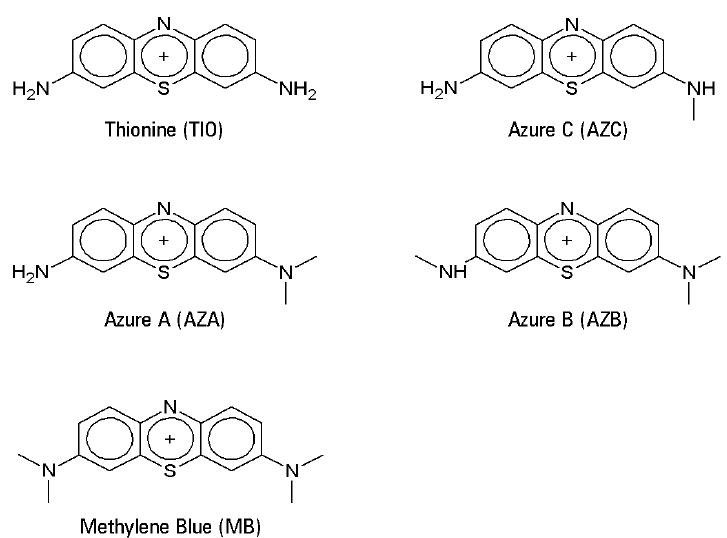
Figure 2. Azure C (monomethylated), Azure A ( N , N -dimethylated), Azure B (trimethylated), and Methylene Blue (tetramethylated) are derivatives of thionine.